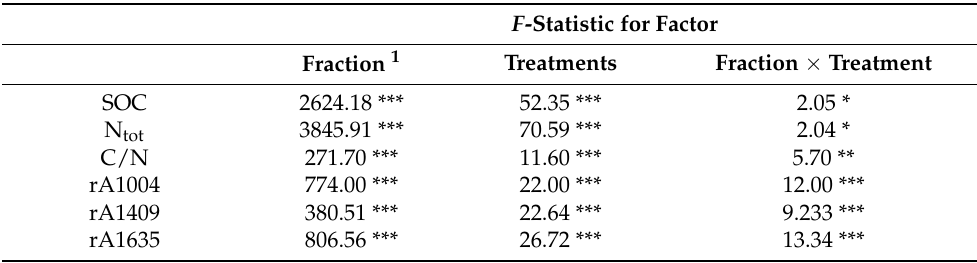
Table 7. ANOVA results for soil organic carbon (SOC), total nitrogen (N tot ), C/N ratio, and relative absorbances (rA) of functional groups at different